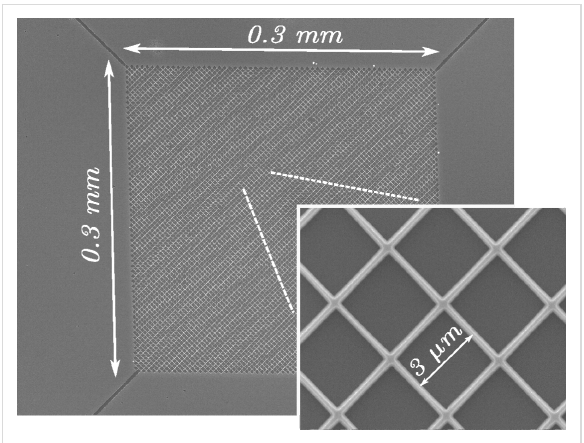
Figure 10: Composition of SEM images of a large area network, made of silicon nanowires 3 μ m